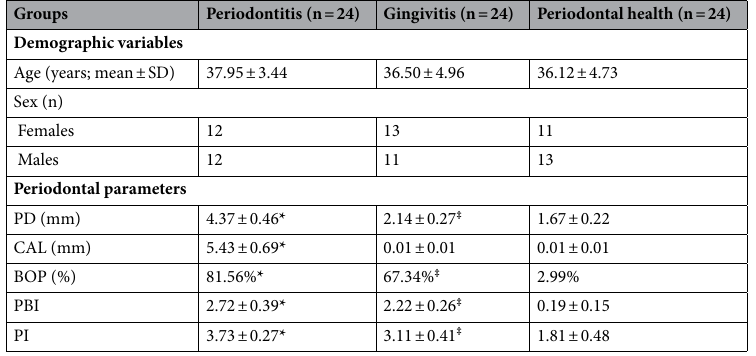
Table 1. Demographic variables and whole-mouth clinical periodontal parameters of study groups. All data (except for sex) are given in terms of mean ± SD. *p < 0.05, significantly higher than the gingivitis and healthy groups. ‡ p < 0.05, significantly higher than the healthy group. PD probing depth, CAL clinical attachment loss, BOP (%) the percentage of the bleeding on probing, PBI papillary bleeding index, PI plaque index, SD standard deviation, n number, mm millimeter.